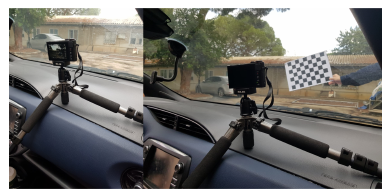
Figure 6: Setups for the real-world